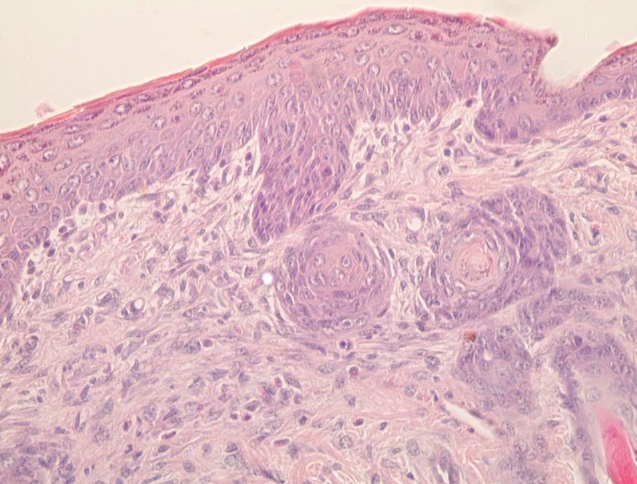
Figure 16. The structure of the newly formed epidermis in the control group (stained with hema- toxylin and eosin. Magnification ×400).